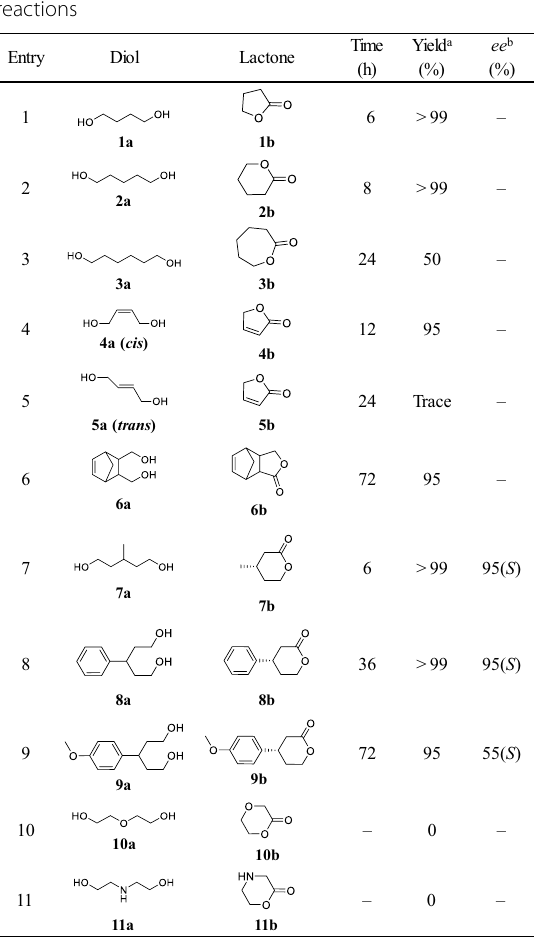
Table 2 HLADH–SBFC-catalyzed